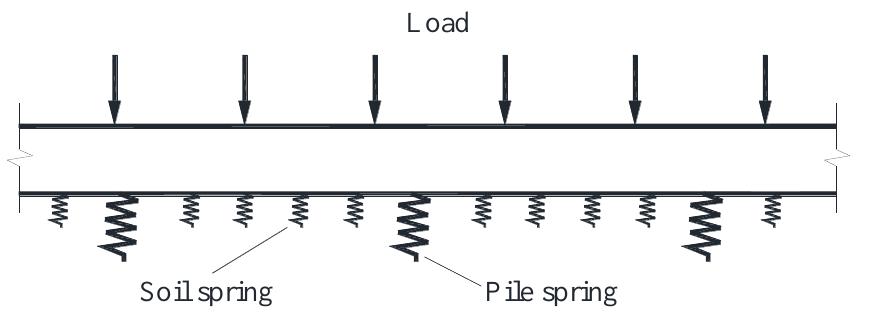
Figure 3. Mechanical model of piled raft foundations with deformation adjustors.